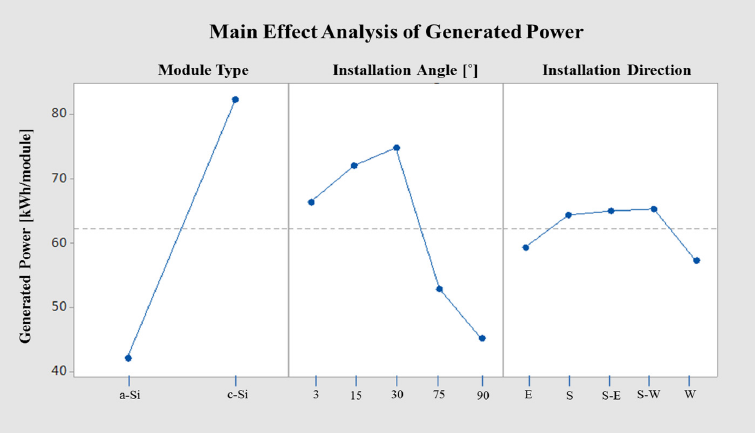
Figure 14. Main e ff ect analysis of the cumulative power generation over one year for di ff erent PV Figure 14. Main effect analysis of the cumulative power generation over one year for different PV module types, installation directions, and module types, installation directions, and angles.